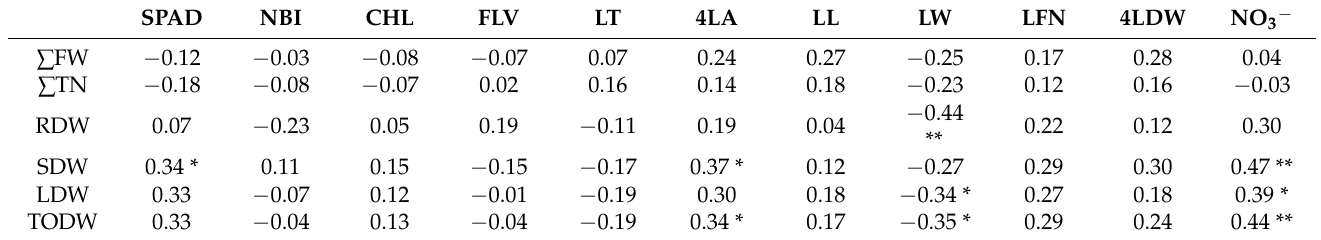
Table 6. Pearson’s correlation coefficients between 4th leaf indexes at 21 DAT and potato plant parameters evaluated at different harvests in response to modified Furlani’s nutrient solution to generate a prognosis for the yield of nuclear seed